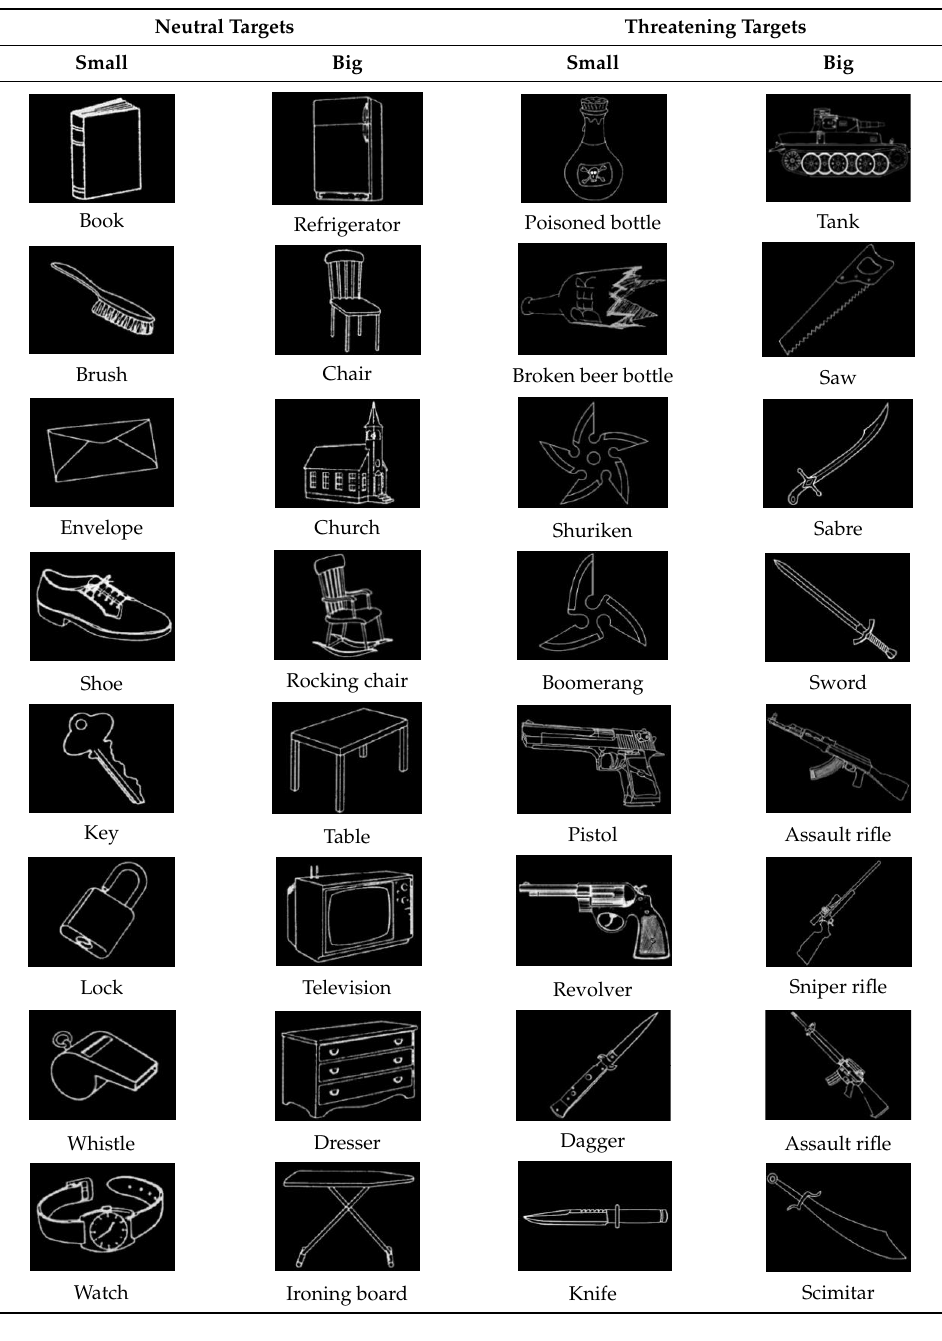
Table A1. List of target stimuli.